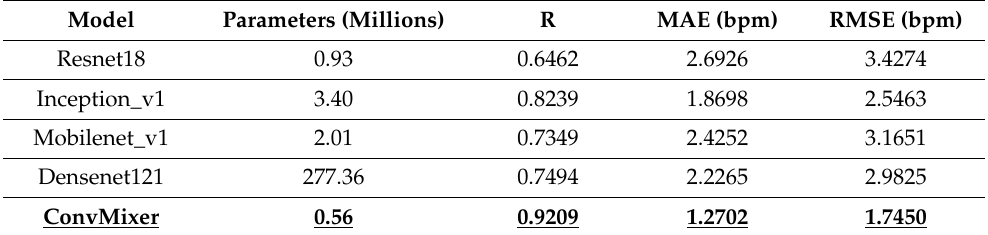
Table 2. Evaluation of five convolution neural networks using fivefold cross-validation.